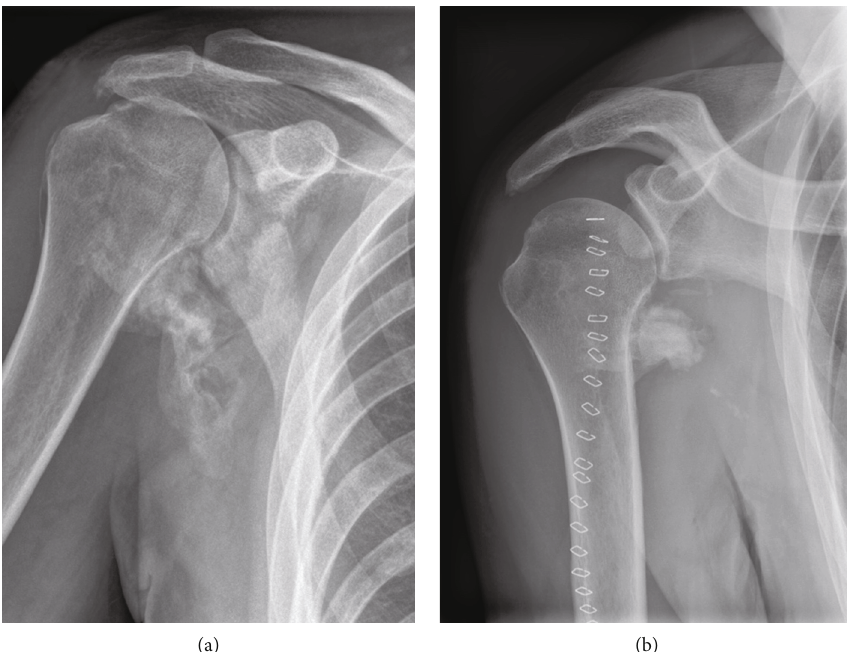
Figure 2: (a, b) AP radiograph demonstrating the extent of the HO one week before (a) and two days after (b) surgery. A small residual of the HO remained